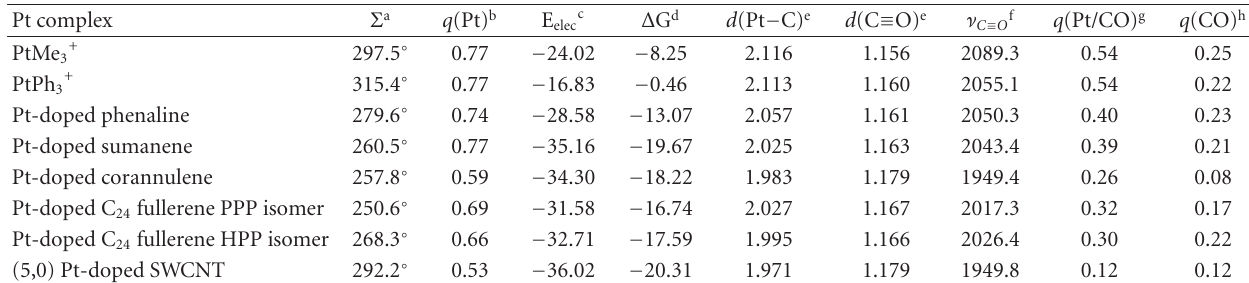
Table 6: Electronic structural data for alkyl- and arylplatinum complexes and their C O adsorbates [45].